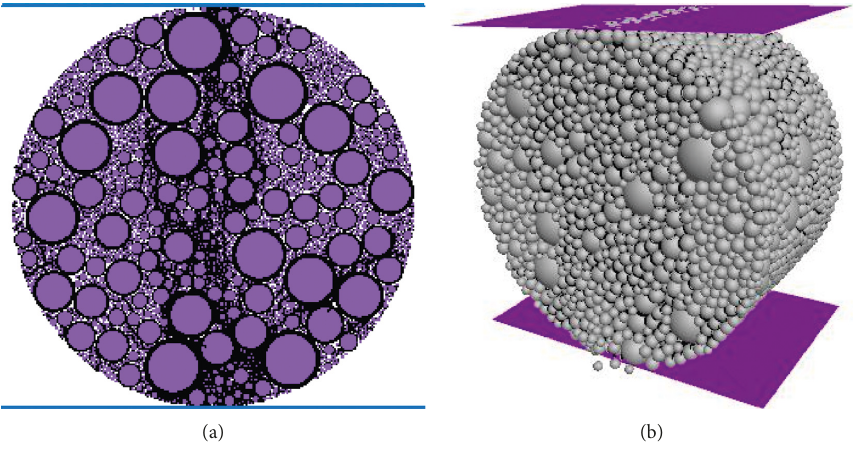
Figure 5: Simulating the splitting test by DEM. (a) Two-dimensional model. (b) Three-dimensional